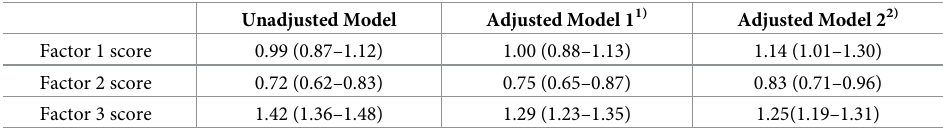
Table 2. Unadjusted and adjusted models of Cox